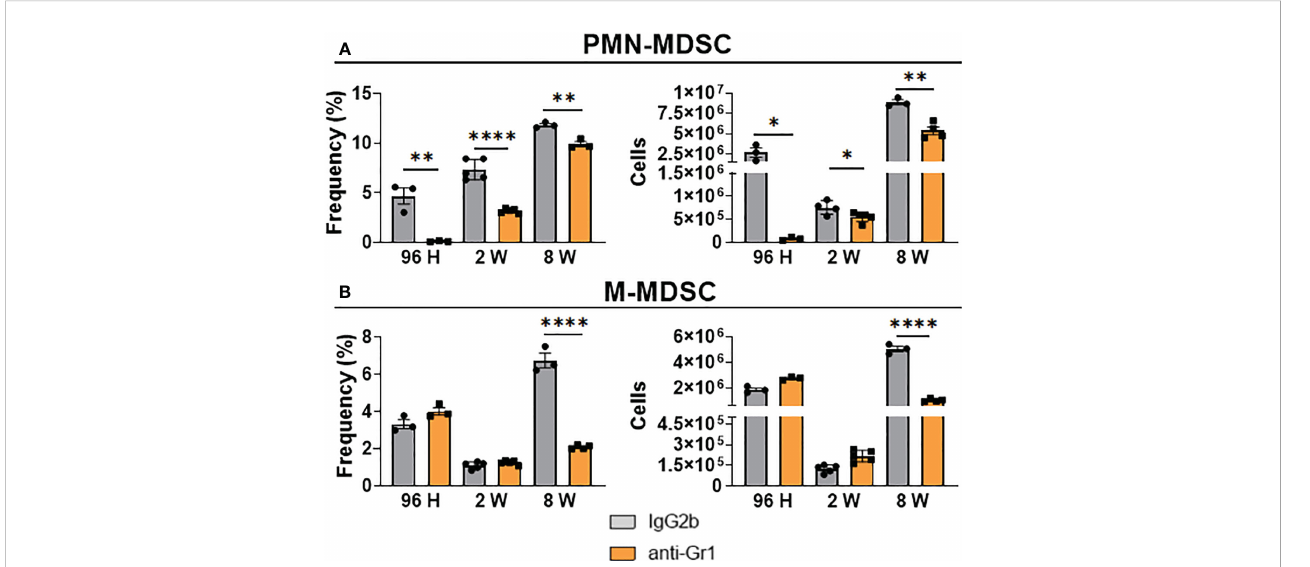
FIGURE 5 Effect of MDSCs depletion by anti-Gr1 treatment in the presence of pulmonary PMN-MDSCs and M-MDSCs at different periods of P. brasiliensis infection. C57BL/6 WT mice were infected i.t. with 1×10 6 yeasts cells of P. brasiliensis . After 24 hours, 1 week, and 7 weeks of infection a group of mice received intraperitoneal injections of anti-Gr1 antibody (clone RB6-8C5) or rat IgG2b isotype control antibody (200 µg/dose). After 96 hours, 2 weeks, and 8 weeks of infection lungs were removed, leukocytes were obtained and the frequency and number of PMN-MDSCs (A) and M-MDSCs (B) subsets were analyzed by fl ow cytometry. Data represent 3 independent experiments with 3-4 mice each. For comparisons between two groups, the mean ± SEM was obtained and analyzed by the unpaired Student ’ s t -test. Differences were considered signi fi cant when: * p <0.05; ** p <0.01 and **** p